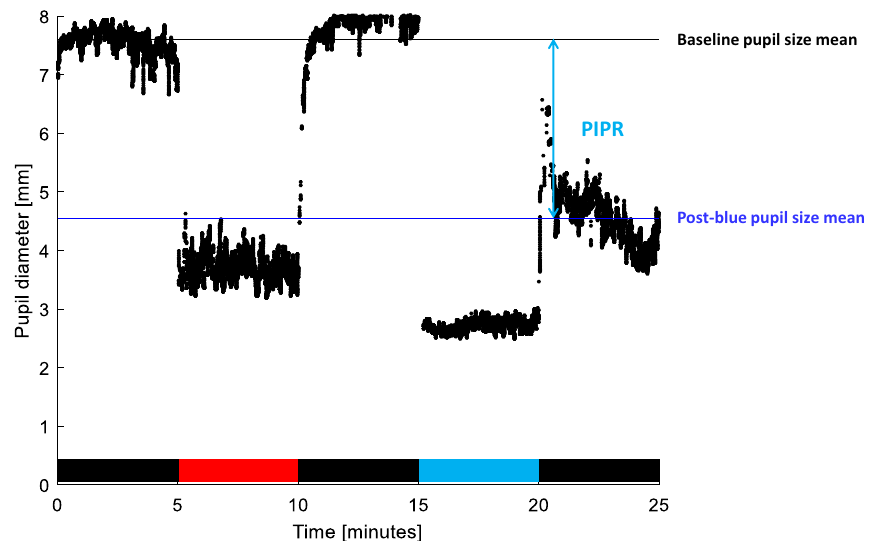
Figure 1. Example of pupil diameter change during pupillometry protocol. The post-illumination pupil response represents the difference of diameter between the first period of darkness and the post-blue darkness (PIPR) 23 . For each block of 5-min, the pupil diameter was averaged on the three central minutes. The absolute PIPR (1) and the relative PIPR (2) were calculated as follows: (1) Absolute PIPR (mm) = (averaged baseline pupil diameter) − (averaged post-blue light exposure pupil diameter); (2) Relative PIPR (%) = 100*(PIPRmm)/ averaged baseline pupil diameter. The bottom bar indicates the light exposure sequence: black: darkness, red: monochromatic red light (luminance: 375 cd/m 2 , irradiance: 14.75 log photons/cm 2 /s) and blue: monochromatic blue light (luminance: 375 cd/m 2 , irradiance: 14.57 log photons/cm 2